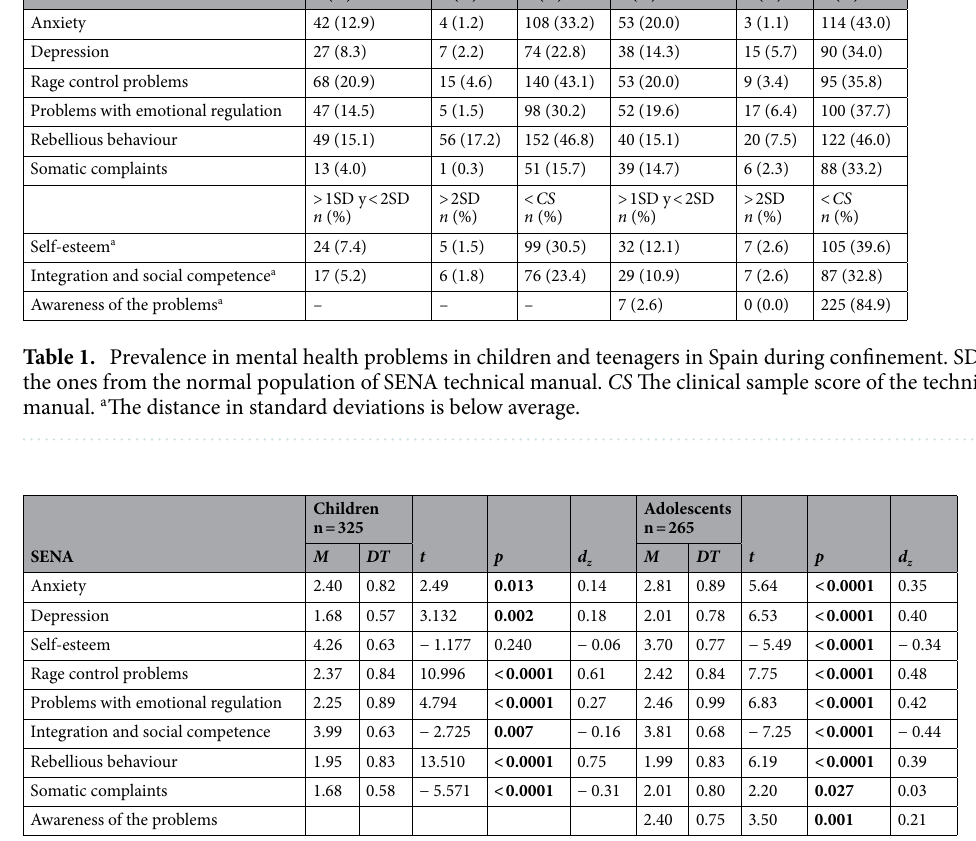
Table 2. Differences between the study sample and SENA scales for children (between 8 and 12 years old) and adolescents (13–18 years old). Statistically significant differences ( p < .05) are highlighted in bold